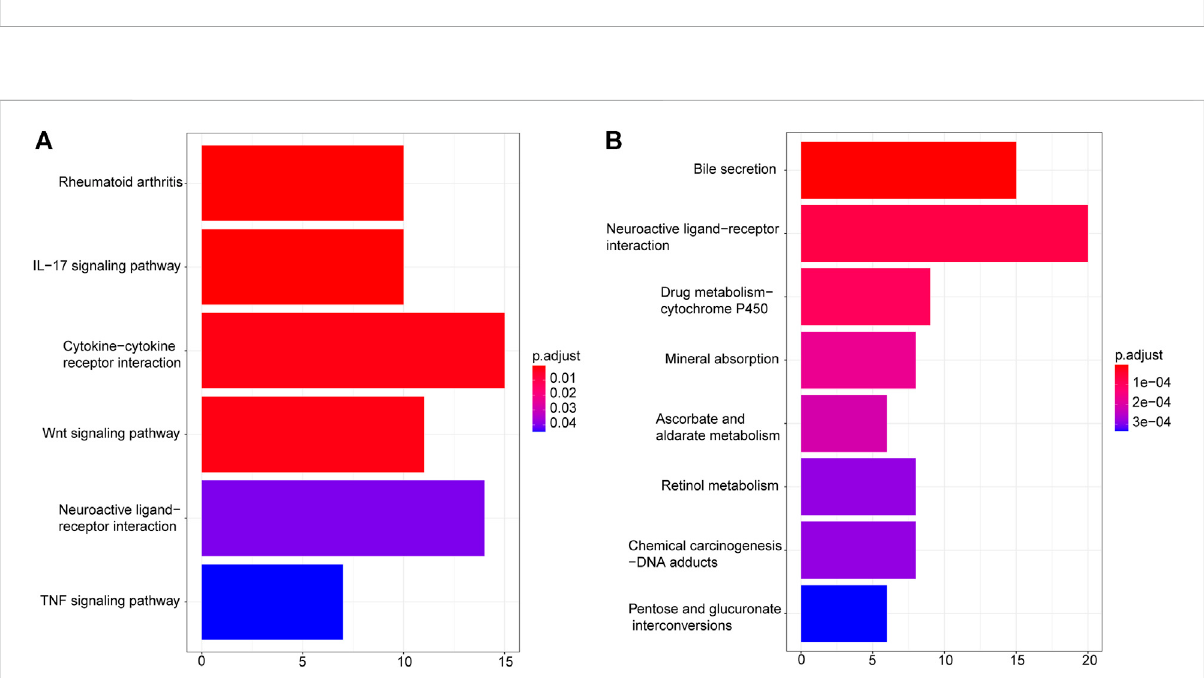
FIGURE 2 Identi fi cation of DEGs between tumor tissues and normal tissues in CRC patients. (A – B) . Differential expression volcanic map of (A) TCGA and (B) GEO dataset. Red dots indicate signi fi cant up-regulation, blue dots indicate signi fi cant down-regulation, and gray dots indicate genes with no signi fi cant changes. (C) . Venn plot for DEGs detected in two datasets.